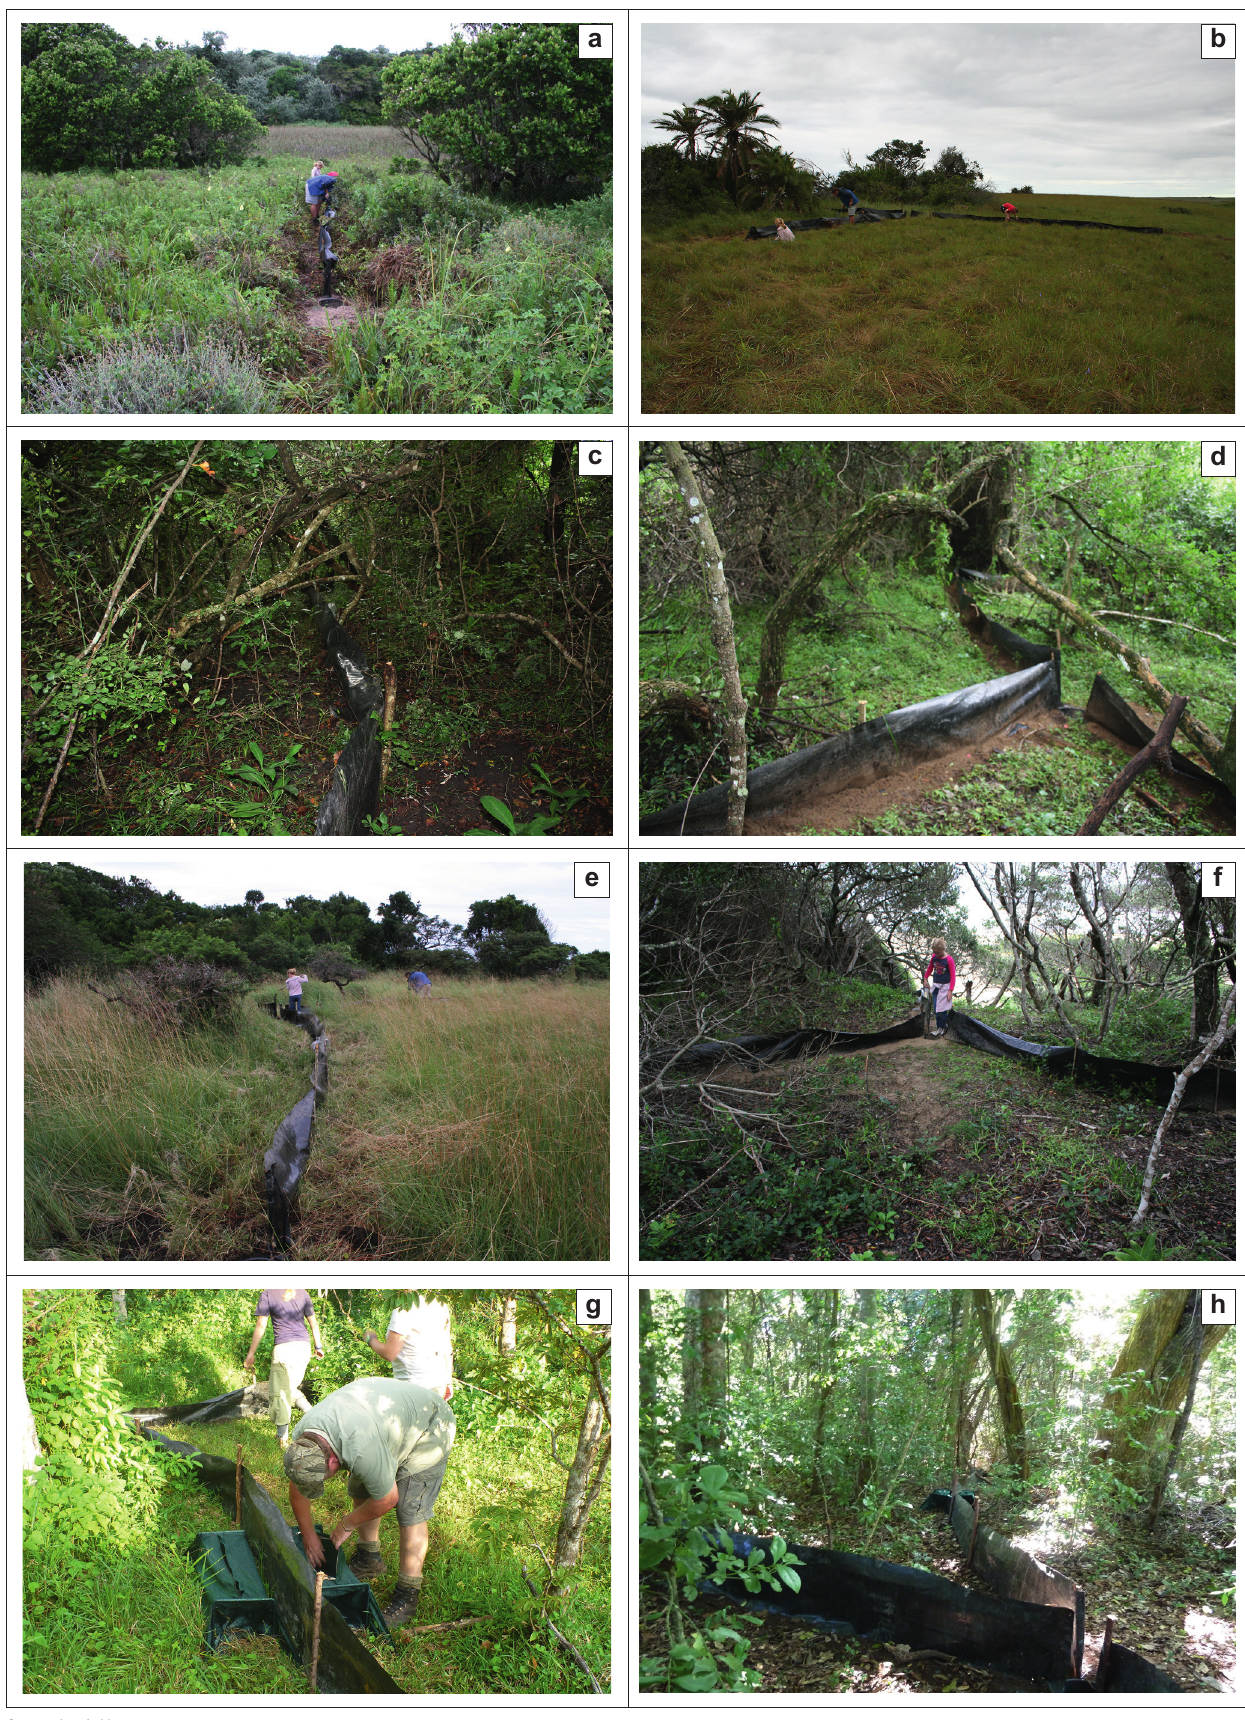
FIGURE 1-A4: (a–ai) Habitat type and trap layout of the respective trap sites surveyed during this study.